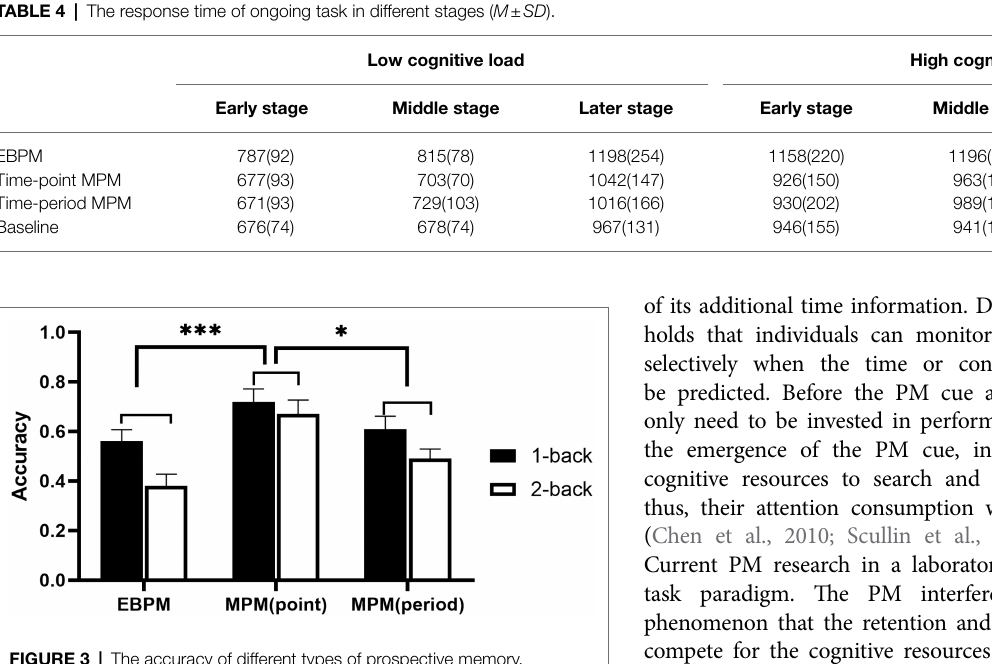
FIGURE 3 | The accuracy of different types of prospective memory. * p < 0.05; *** p <